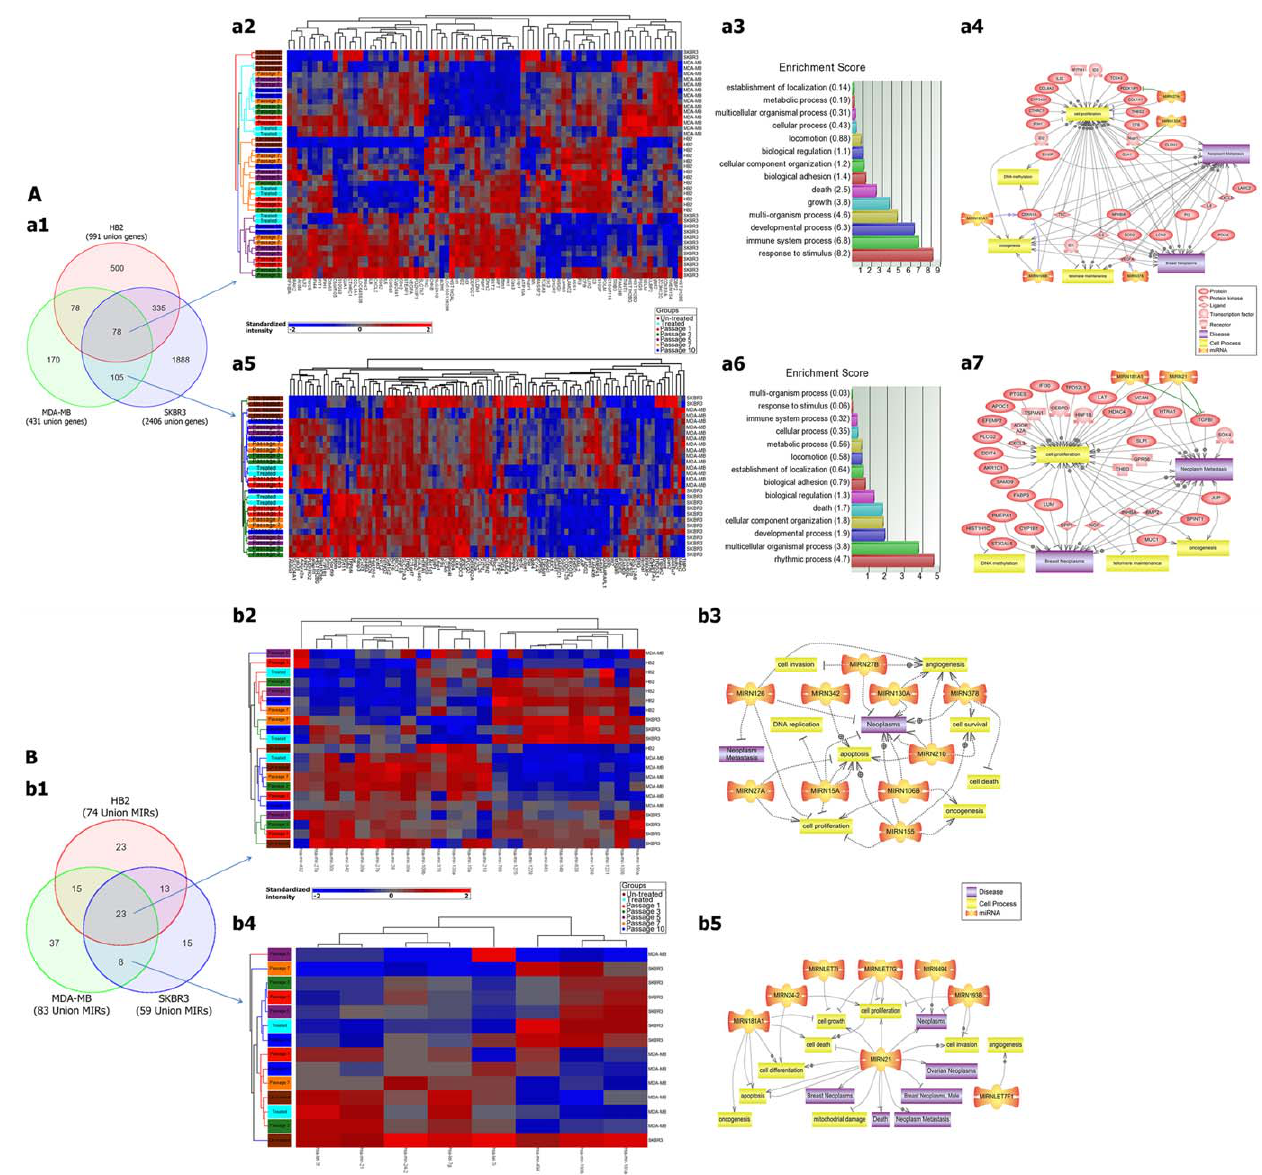
Figure 2. Gene and micoRNA expression matrix. A) Gene expression of HB2, MDA-MB231 and SKBR3 cell lines. a1) The total number of significant up/down-regulated genes within three analyzed cell lines. a2) Expression profiles of 78 intersection genes among all three cell lines as non-cancer specific changes. a3) Gene set analysis of 78 intersection genes. a4) Pathway analysis of 30 out of 78 genes that are linked to breast neoplasms, metastasis and/or cell proliferation. a5) Expression profiles of 105 intersection genes between MDA-MB231 and SKBR3 as cancer specific changes. a6) Gene set analysis of 105 intersection genes. a7) Pathway analysis of 36 out of 105 genes that are linked to breast neoplasms, metastasis and or cell proliferation. B) MicroRNA expression of HB2, MDA-MB231 and SKBR3 cell lines. b1) The total number of significant up/down-regulated miRNAs within three analyzed cell lines. b2) Expression profiles of 23 intersection miRNAs among all three analyzed cell lines as non-cancer specific changes. b3) Pathway analysis of 10 out of 23 miRNAs that are linked to breast neoplasms, metastasis and/or cell proliferation. b4) Expression profiles of 8 intersection miRNAs between MDA-MB231 and SKBR3 as cancer specific changes. b5) Pathway analysis of all 8 miRNAs as cancer specific changes that are linked to breast neoplasms, metastasis and or cell